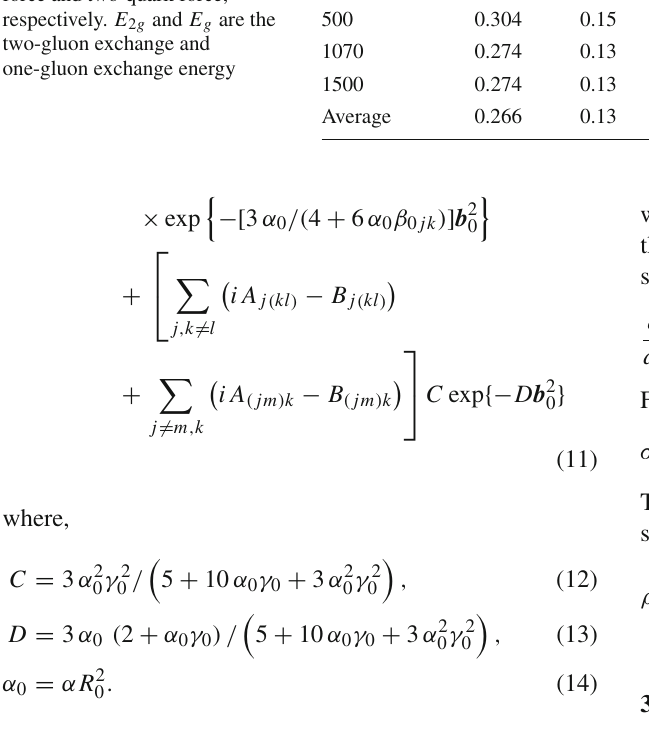
Table 2 The values of radius of quark-quark interaction and gluon quant energy. r th and r t are the radius of three-quark force and two-quark force, respectively. E 2 g and E g are the two-gluon exchange and one-gluon exchange energy